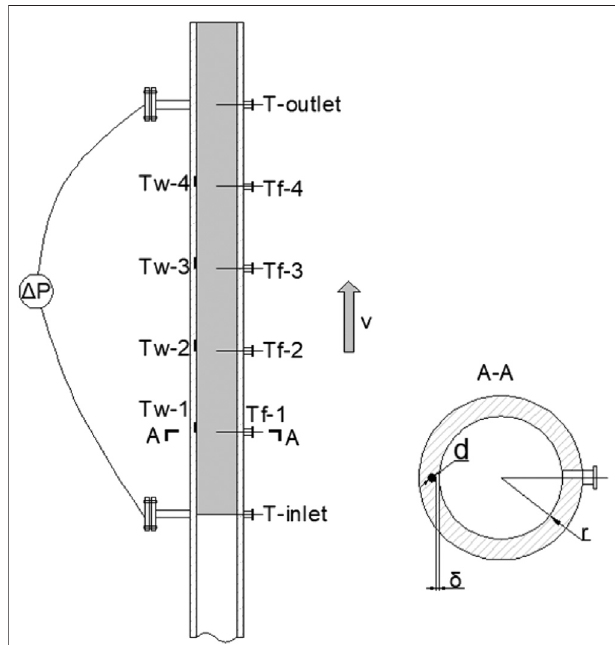
FIGURE 2 | Schematic of the test section.